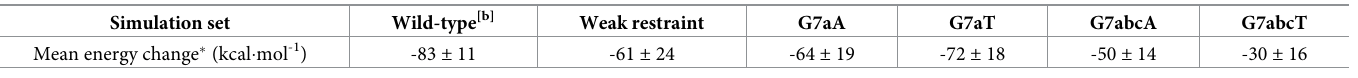
Table 2. Mean energy difference between unfolded and folded ensembles of collagen triple helices Simulation